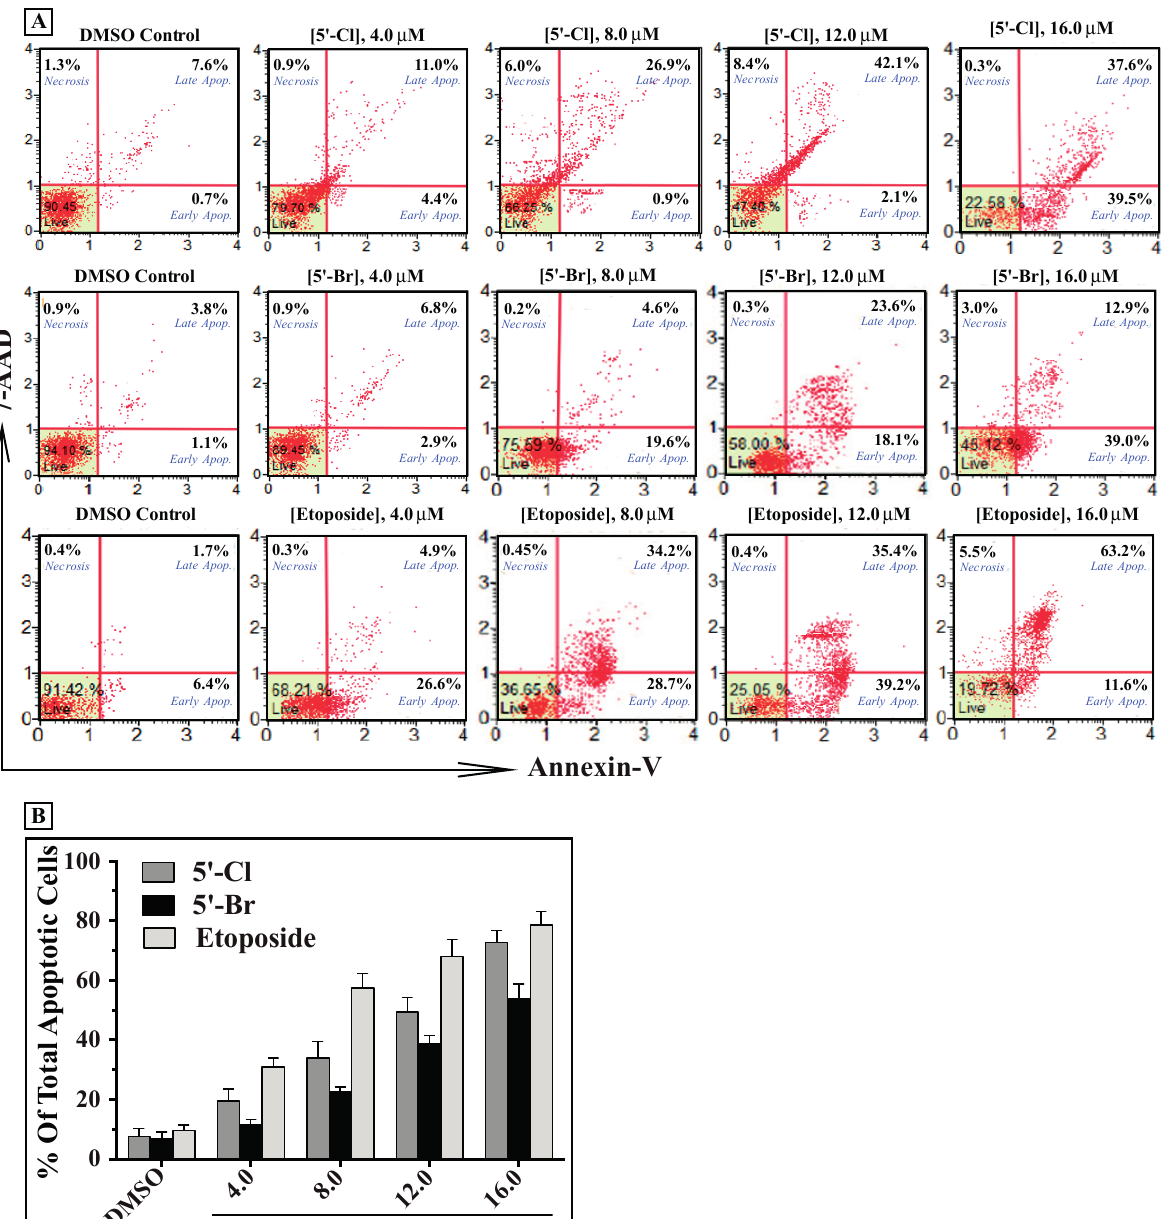
Figure 5. Compounds 3b and 3d induce apoptosis in K562 cells in a dose-dependent manner. Cultured K562 cells were treated with varying concentration of compounds 3b , 3d or etoposide (0.0 to 16.0 μ M) for 24 h and apoptosis was analyzed by a flow cytometer after staining with FITC-annexin-V and 7-AAD as described in the experimental section. The scattered blots ( A ) showing the percentages of early (Annexin + , 7-AAD − ) and late apoptosis (Annexin + , 7-AAD + ), and necrosis (Annexin, 7-AAD + ) are representation of one experiment. The graph ( B ) represents the mean percentages ± SD of total apoptosis (early and late apoptosis) of three independent experiments for each concentration of the test compound. K562 cells were treated with different concentrations of etoposide as positive controls. Statistical analysis showed that all samples are significantly different ( p < 0.05), when compared to their untreated controls